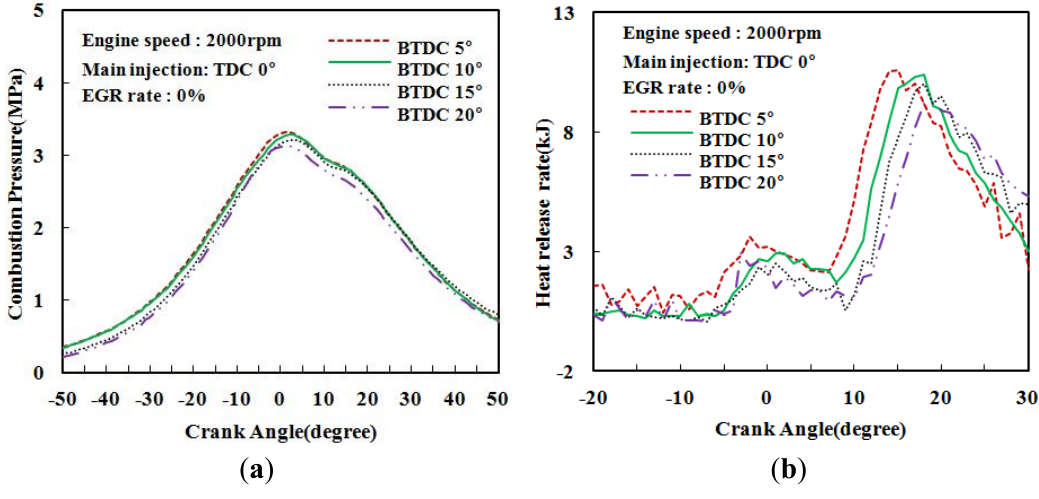
Figure 2. Effects of various pilot injection timings without EGR rate on the ( a ) combustion pressure, and ( b ) HRR.